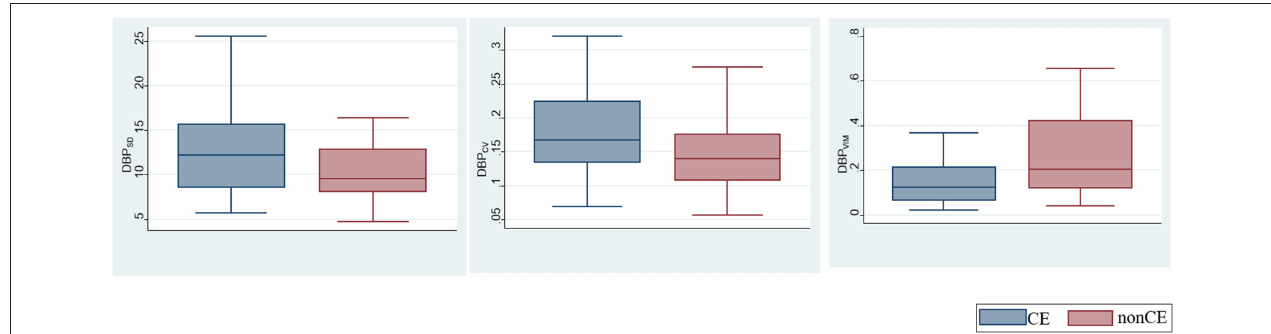
FIGURE 2 | Comparison of blood pressure variability (BPV) parameters according to the mechanisms of stroke.